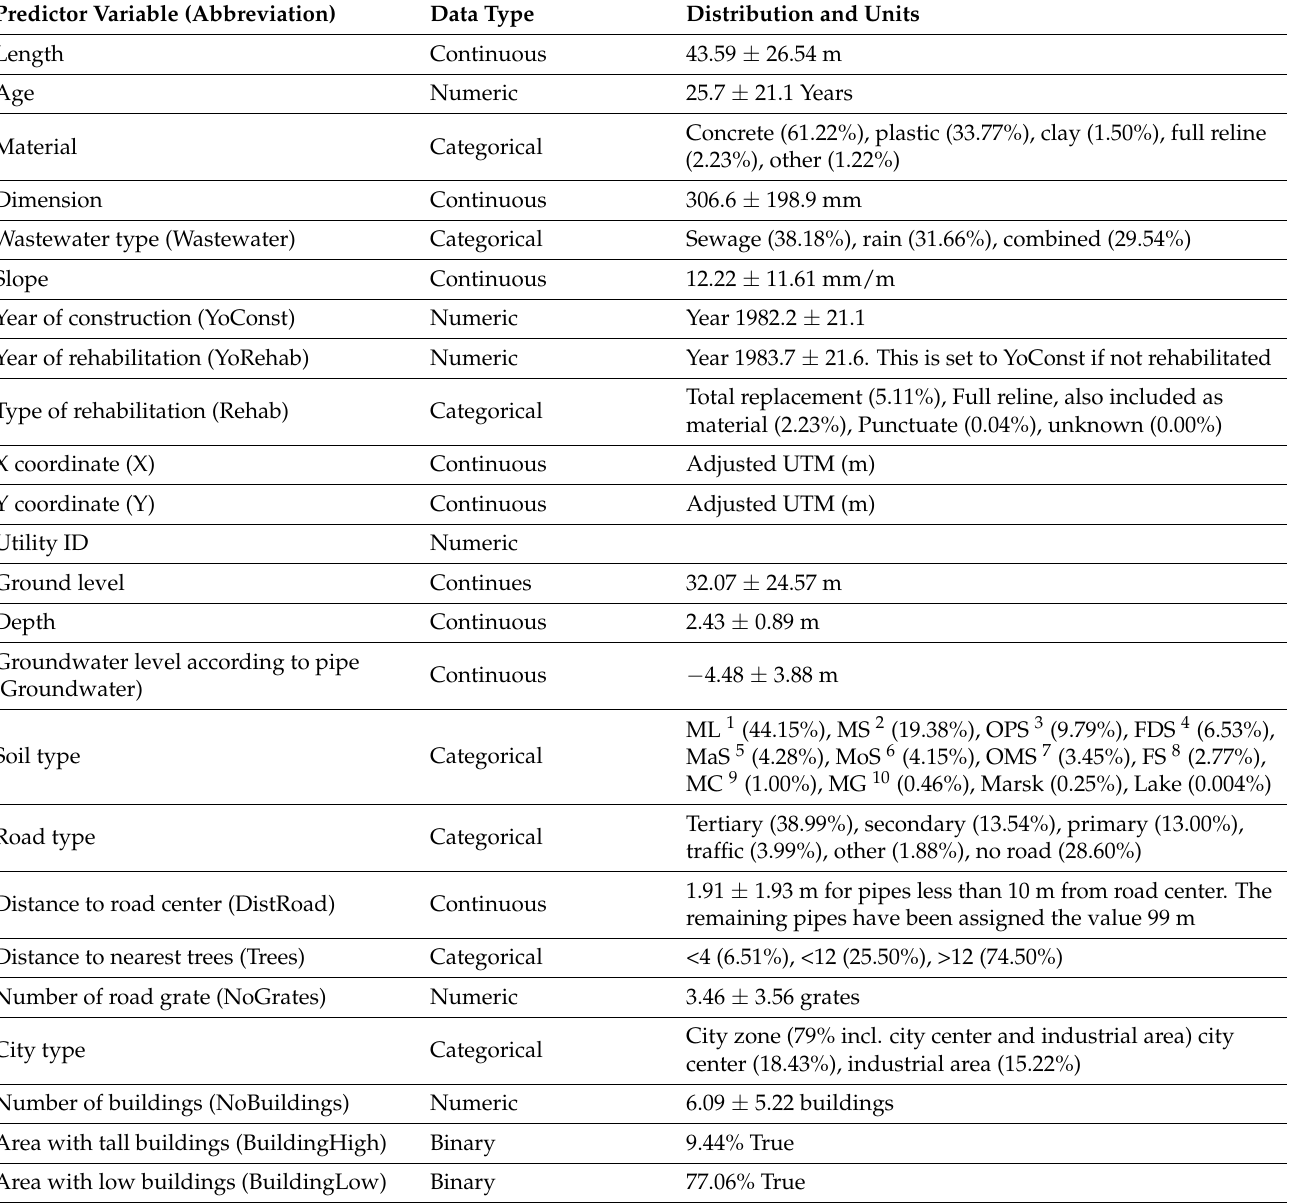
Table 1. Overview of predictor variables and the corresponding data types as well as distribution or units. For continuous and numeric data types, the mean and std are presented. For categorical data types, the percentage of pipes in each category is presented and for binary data types, the percentage of true values is